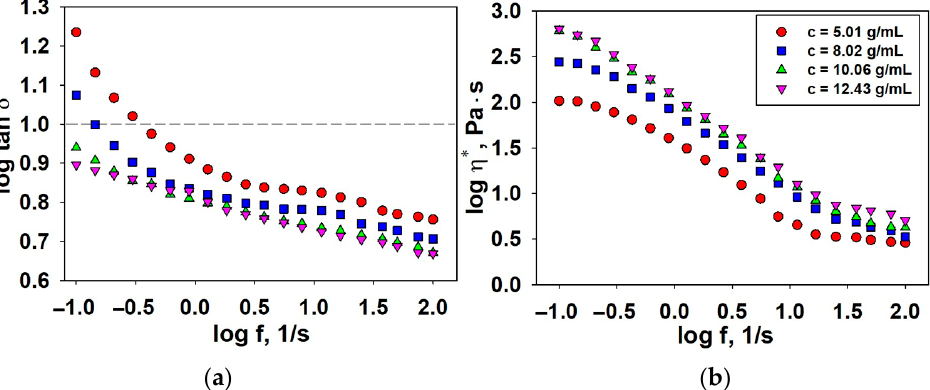
Figure 11. Log–log plots of loss tangent (tan δ , ( a )) and complex viscosity ( η *, ( b )) vs. frequency for PSFEtP + solution at different concentrations. PSFEtP + solution at different